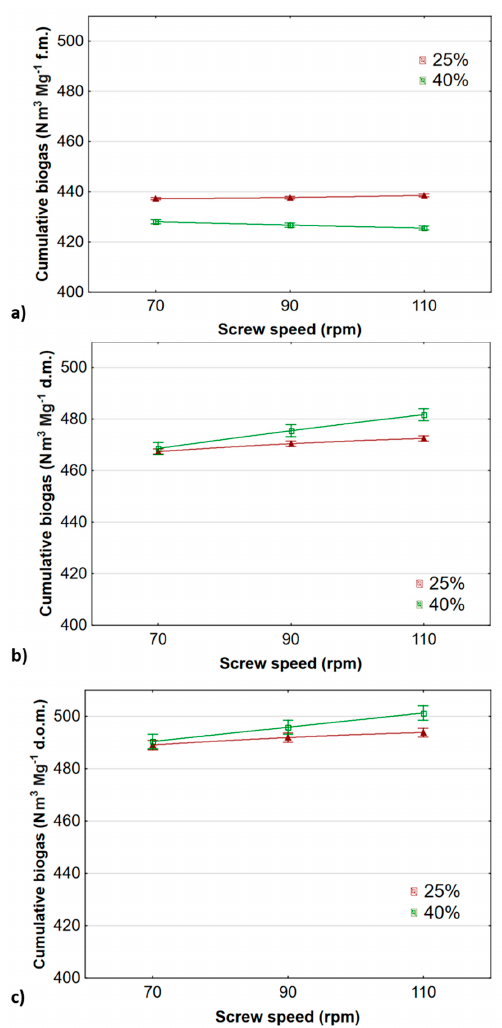
Figure 5. Cumulative biogas efficiency with corn straw subjected to extrusion treatment at various screw speeds and moisture content: ( a ) cumulative biogas for fresh mass, ( b ) cumulative biogas for dry matter, ( c ) cumulative biogas for dry organic matter.